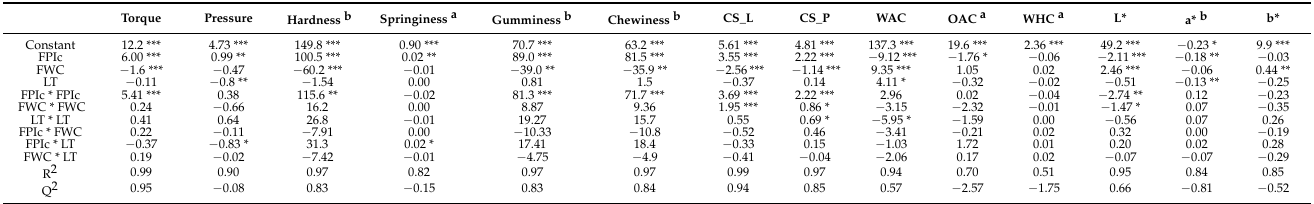
Table 3. Results of the multiple linear regression (MLR) analysis. Parameter estimates for the linear and quadratic effects and interactions of FPIc (content of faba bean protein isolate), FWC (feed water content), and LT (long cooling die temperature) on torque and pressure at the die, and on the hardness, springiness, gumminess, chewiness, cutting strength longitudinal (CS_L), cutting strength perpendicular (CS_P), water absorption capacity (WAC), oil absorption capacity (OAC), water hydration capacity (WHC), and the colour parameters L*, a*, and b* of the meat analogues.